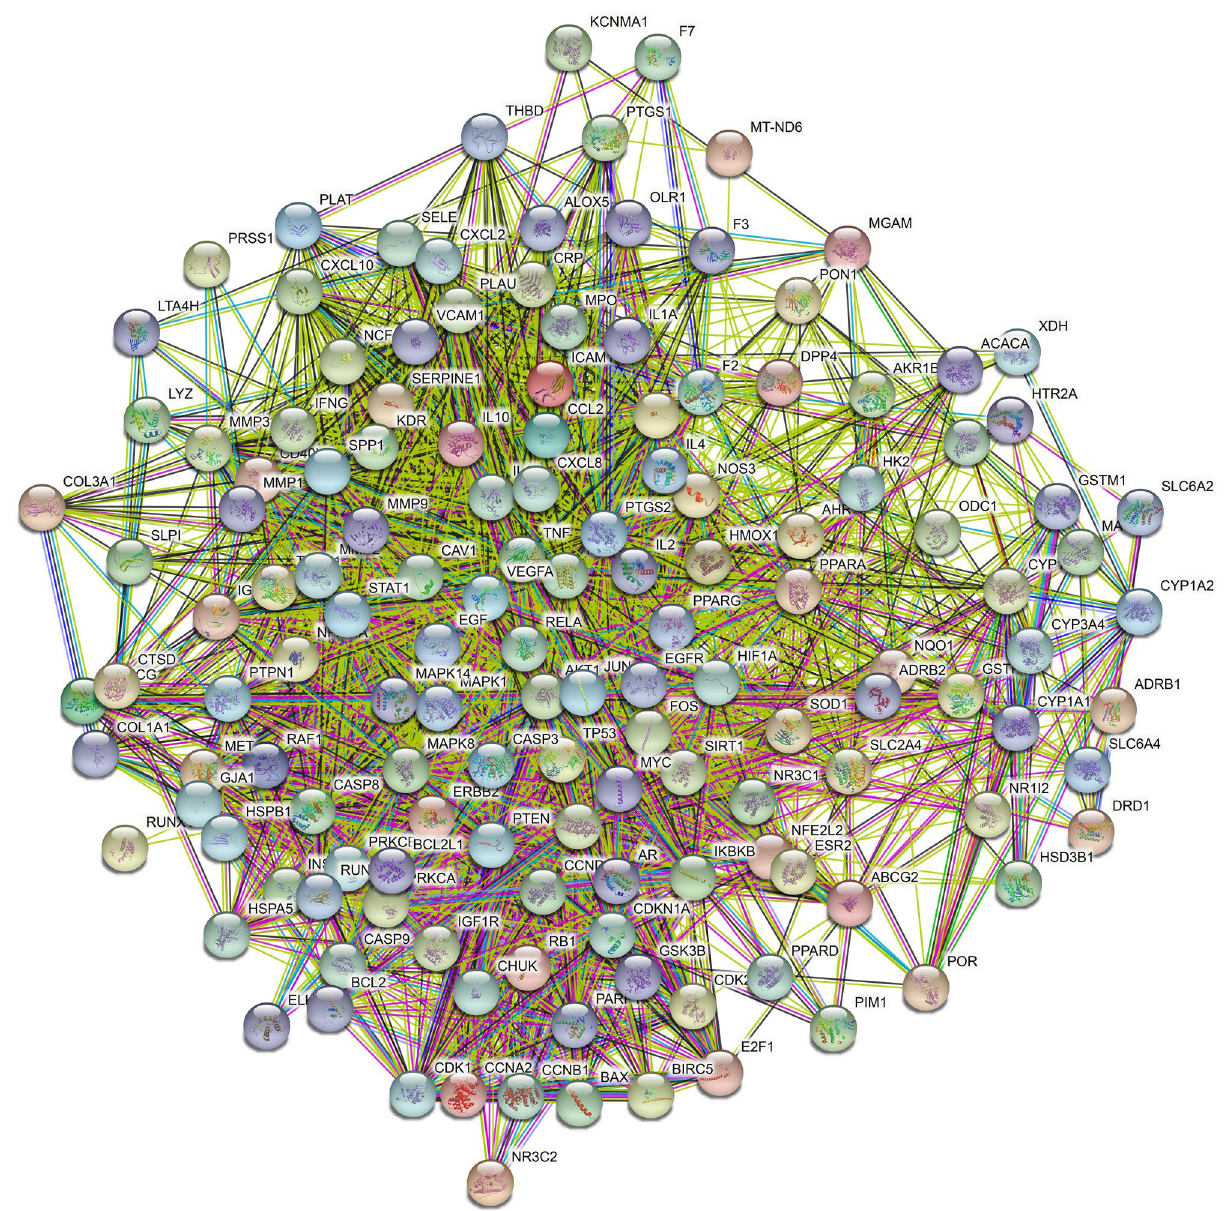
Figure 5. PPI network. Network nodes represent proteins: colored nodes represent query proteins and the first shell of interactors; white nodes represent the second shell of interactors; empty nodes represent proteins of unknown 3D structure; filled nodes represent some 3D structure that is known or predicted. Edges represent protein–protein associations: the light blue edges represent from curated databases; the fuchsia edges represent experimentally determined; the green edges represent gene neighborhood; the red edges represent gene fusions; the dark blue edges represent gene co-occurrence; the light green edges represent text mining; the black edges represent co-expression; the light purple edges represent protein homology. The thickness of the line in the figure represents the strength of the